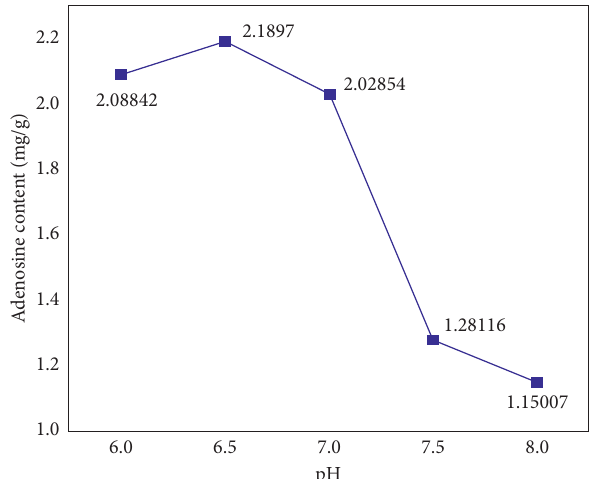
Figure 3: Effect of the pH values on adenosine content.